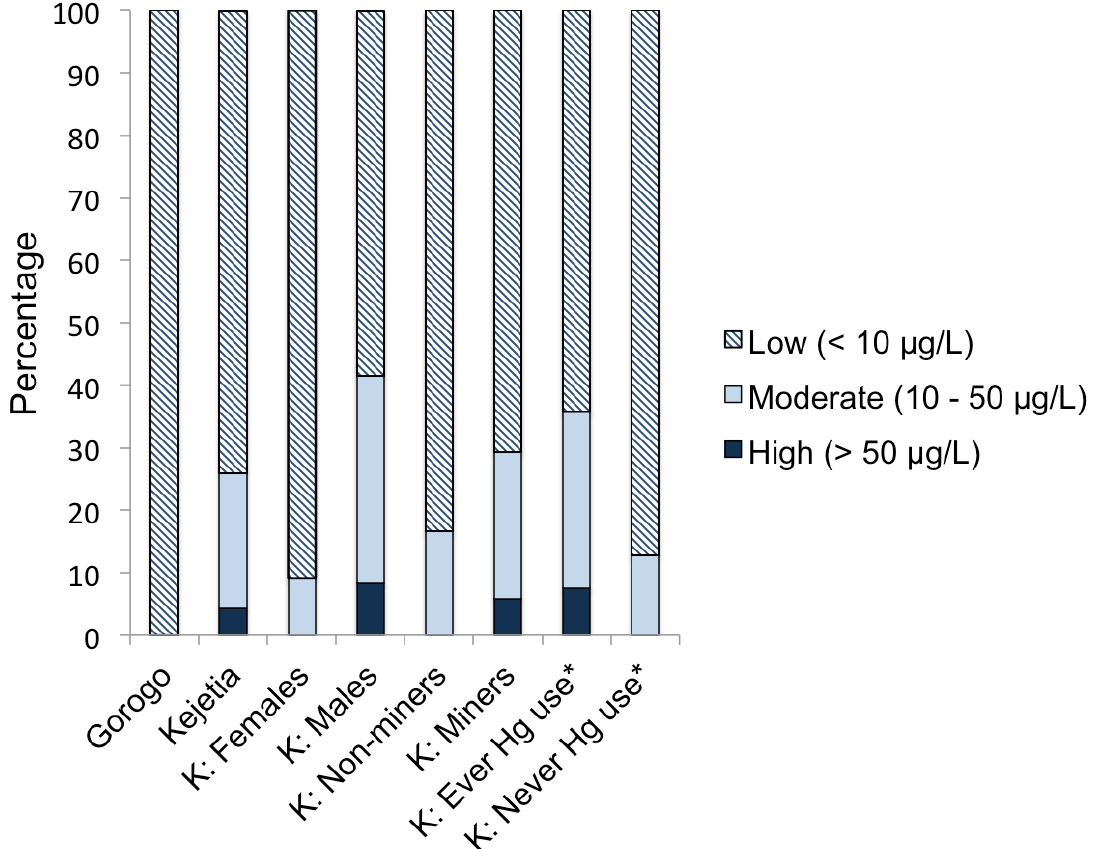
Figure 5. Percentage of participants with low (<10 µg/L), moderate (10–50 µg/L), and high (>50 µg/L) SG-Urinary Hg. * Ever Hg use includes ever involvement in amalgamation or